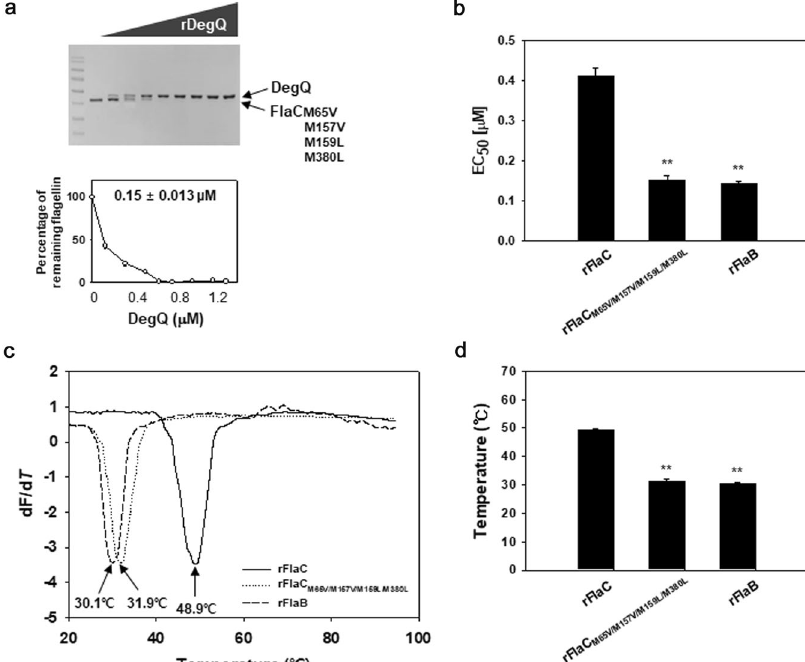
Fig. 7 In vitro proteolysis of the mutagenized FlaC. a , b Proteolysis of FlaC M65V/M157V/M159L/M380L by DegQ. Mutagenized FlaC (1 μ M), in which four Met residues at the 65, 157, 159, and 380th positions were substituted with the amino acids at the corresponding positions in FlaB (as shown in Supplementary Fig. 5b), were incubated with various concentrations of rDegQ (0, 0.12, 0.3, 0.48, 0.6, 0.72, 0.9, 1.08, and 1.2 μ M). As described in Fig. 5, the remaining FlaC M65V/M157V/M159L/M380L in reaction mixtures were resolved in SDS-PAGE (the gel image), and their relative amounts were plotted against the given concentrations of rDegQ with the calculated values of EC 50 ( a ). The average values of EC 50 for proteolysis of the FlaC M65V/M157V/M380L by rDegQ were obtained from three independent proteolysis assays. For comparison, those of the original rFlaC and rFlaB were included ( b ). The error bars on the bar graph represent standard deviation. The P- values for comparison with the original FlaC were indicated (Student ’ s t -test; ** P < 0.005). c , d Determination of the stability of the original and mutagenized fl agellins. Thermal denaturation pro fi les of rFlaB, rFlaC, and rFlaC M65V/M157V/M159L/M380L were monitored by measuring the intensity of a fl uorescent dye, SYPRO Orange, which had been labeled to the recombinant proteins (1 μ M each), as described 63 . The melting temperatures ( T m ) of each recombinant polypeptide, at which the lowest value of − dF/d T pointed, were obtained, as described in “ Methods ” ( c ). The average values of T m of each recombinant polypeptide were obtained from three independent experiments ( d ). The error bars on the bar chart represent standard deviation. The P- values for comparison with the original rFlaC were indicated (Student ’ s t -test; ** P <